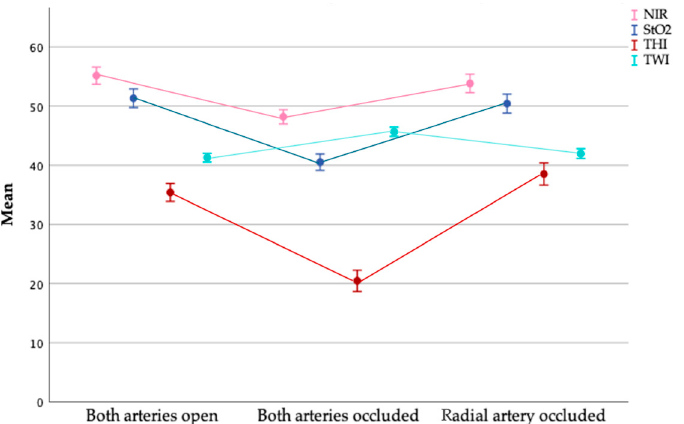
Figure 5. Measurements of the hyperspectral analysis over the time course of the experiment. The measured value at time point I symbolizes the baseline measurement, at time point II the values under occlusion of both vessels and at time point III the measured values after opening the ulnar artery. The NIR values (near infrared index/deep perfusion) are shown in pink, the StO 2 values (superficial perfusion) in blue, the THI (tissue hemoglobin index) in red and the TWI (tissue water index) in cyan.